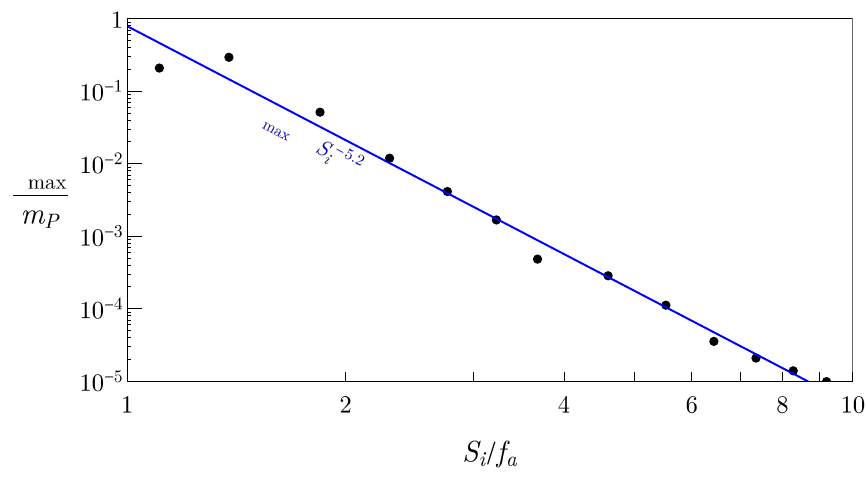
Figure 6 . Parametric resonance rate µ max as a function of the radial field value S i . The black data points obtained numerically suggest a scaling law of µ max ∝ S n